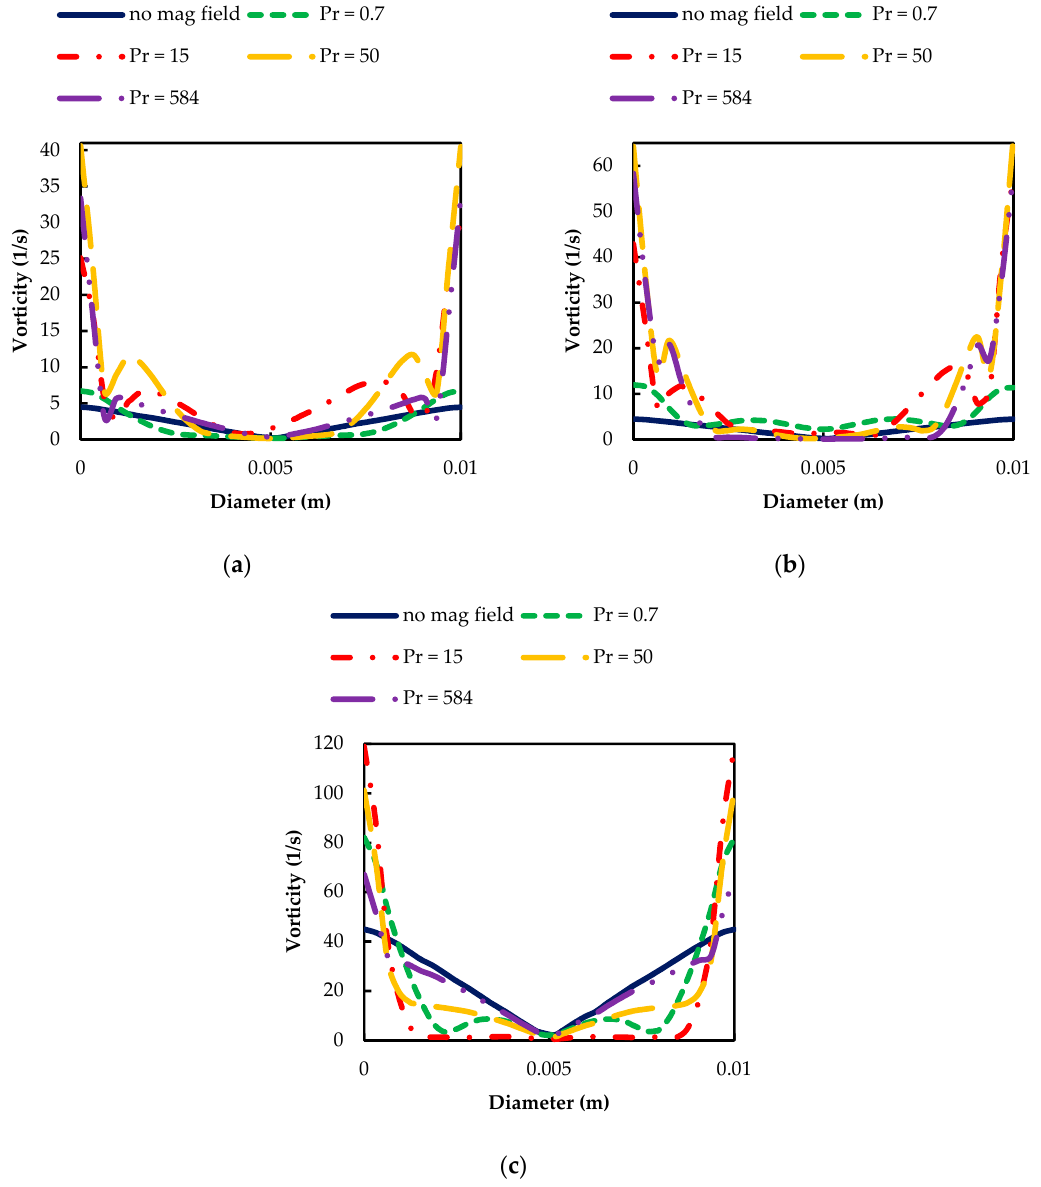
Figure 16. Vorticity profiles obtained for the studied cases in the cross-section placed 0.005 m behind the magnetic coil: ( a ) Re = 1, b 0 = 5 T, ( b ) Re = 1, b 0 = 10 T, ( c ) Re = 10, b 0 = 5 T.